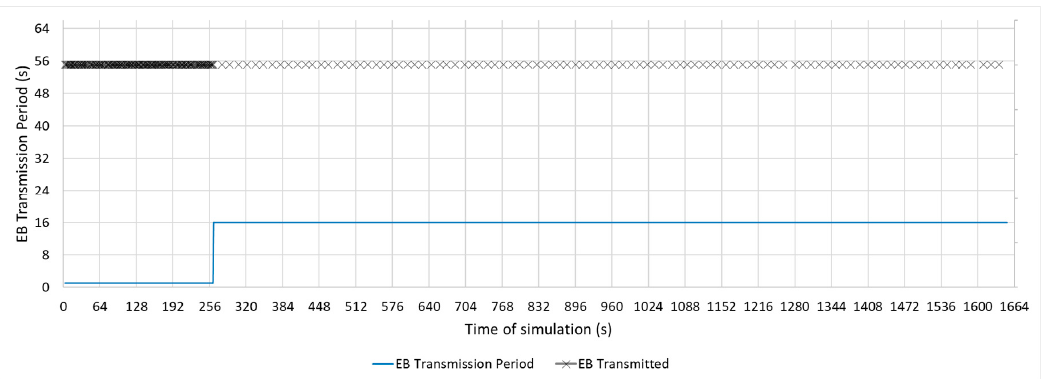
Figure 12. M16s configuration.